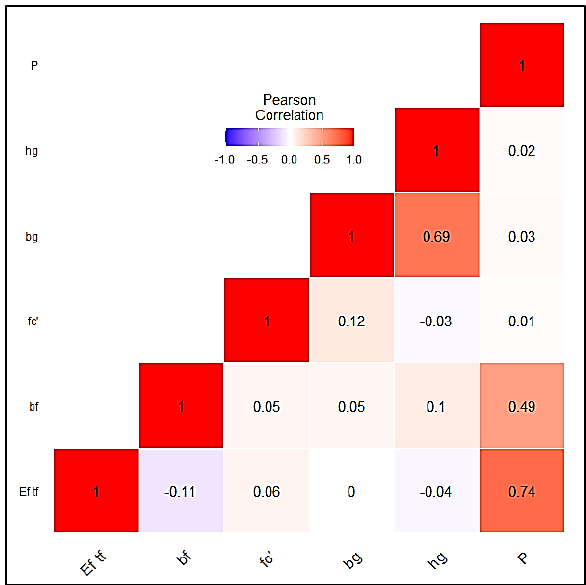
Figure 3. Pearson correlation with heat map. Table 1. Descriptive statistics of the collected dataset.